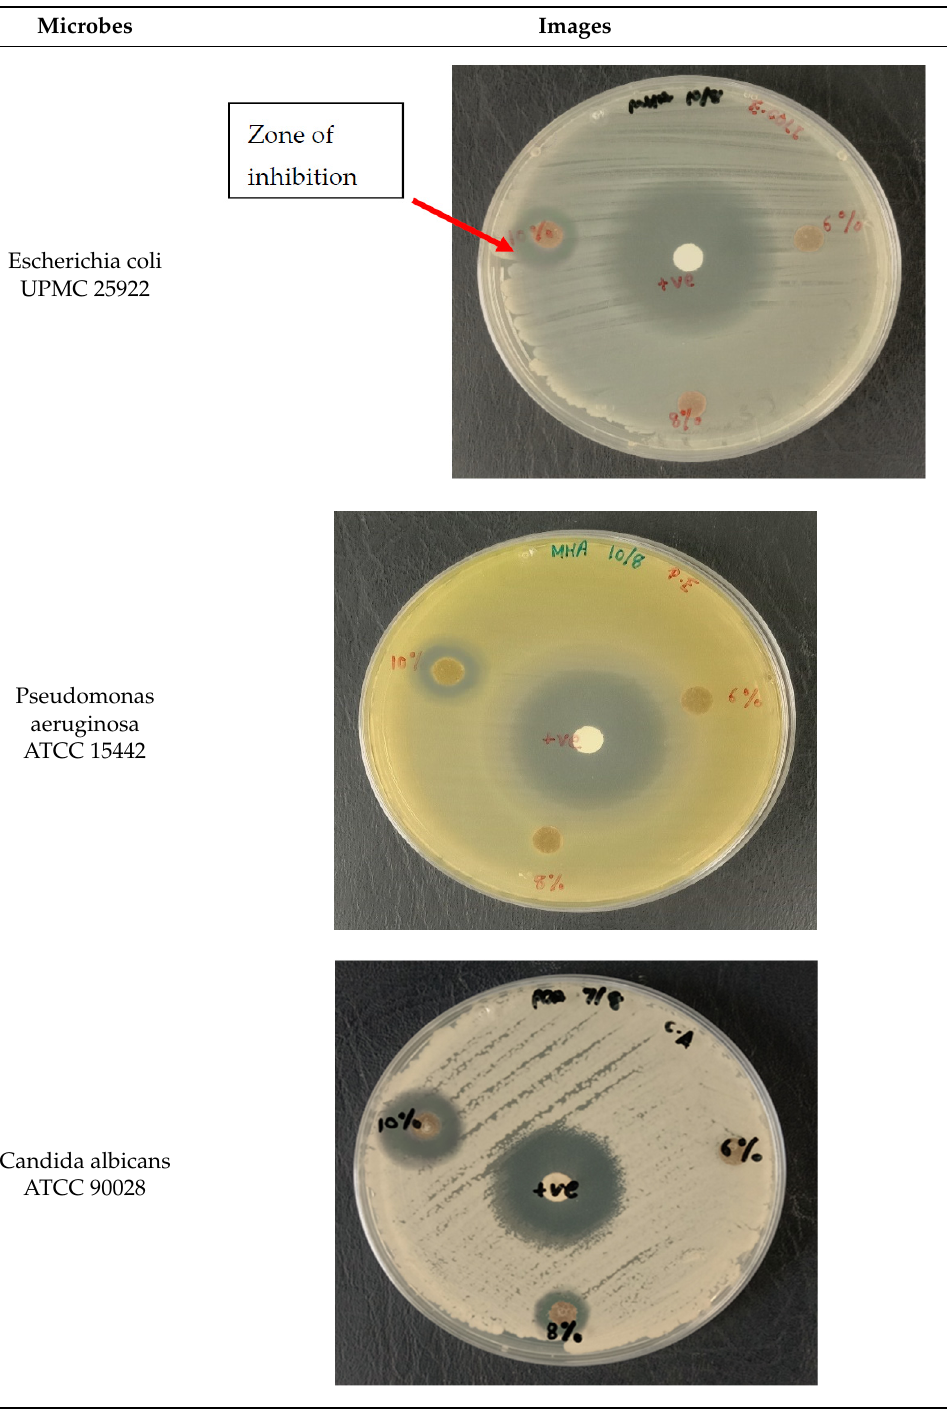
Table 6. Positive tests for antimicrobial properties on E. coli, P. aeruginosa and C. albicans using the agar disk diffusion method .